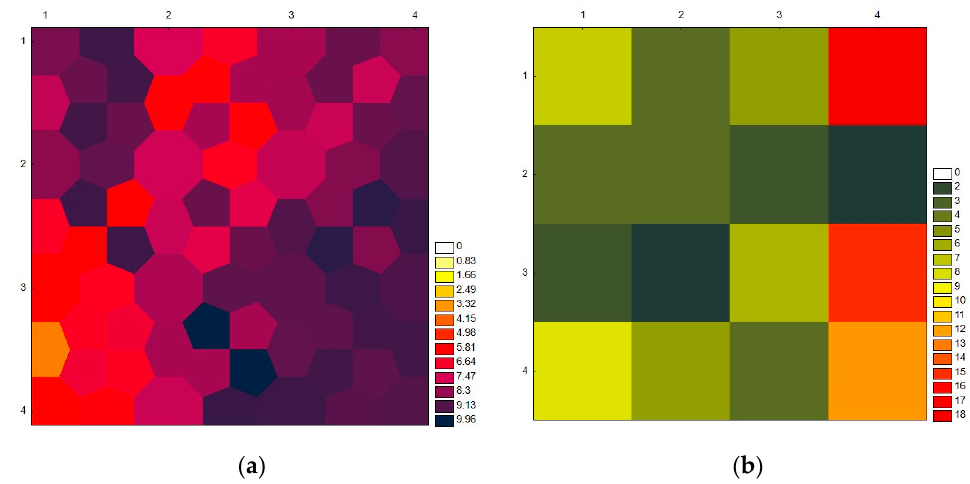
Figure 1. Distribution of SOM: ( a ) distances between neurons of a KNN model for the determination of the neighborhood; ( b ) distribution of the study participants among each neuron while accounting for the 171 study-related variables.